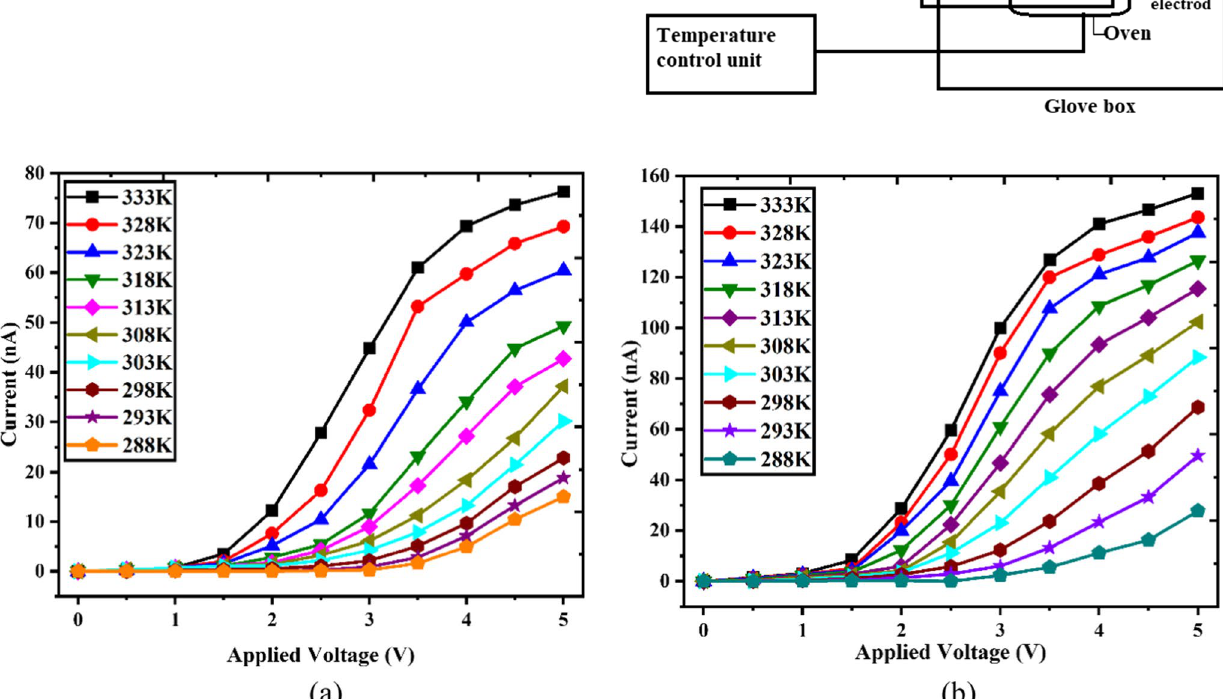
Fig.4 Schematic circuit diagram of temperature-dependent I–V–T characteristics of a TZ Dye without TiO